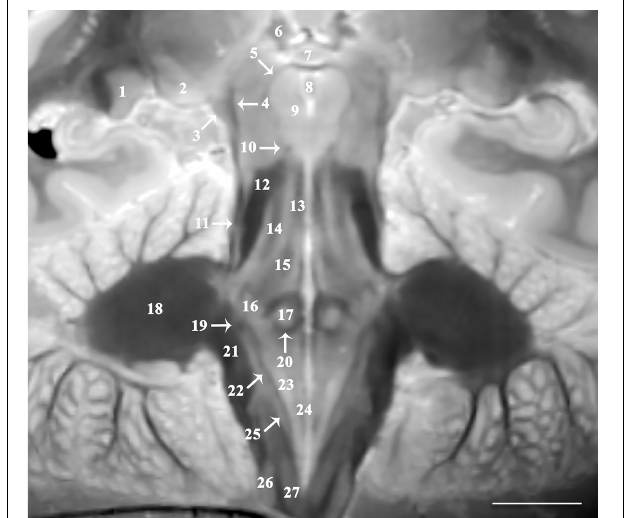
FIGURE 2 | Image oriented parallel and deep to the rhomboid fossa that is 15 o anterosuperior-to-posteroinferior oblique to the coronal intercommissural plane provides excellent visualization of lateral (1) and medial geniculate nuclei (2), brachium of the inferior colliculus (3), spinothalamic tract (4), mesencephalic trigeminal nucleus (5), habenular nucleus (6), posterior commissure (7), cerebral aqueduct (8), oculomotor nucleus (9), trochlear nerve (10), lateral lemniscus (11), superior cerebellar peduncle (12), medial longitudinal fasciculus (13), central tegmental tract (14), mesencephalic trigeminal tract (15), trigeminal nucleus (16), abducens nucleus (17), middle cerebellar peduncle (18), vestibular division of the vestibulocochlear nerve (19), genu of facial nerve (20), inferior cerebellar peduncle (21), solitary tract (22), dorsal motor vagal nucleus (23), hypoglossal nucleus (24), solitary nucleus (25), cuneate (26), and gracile nucleus (27) [scale bar = 10 mm]. Note the proximal optic radiations forming the dark lateral border of the lateral geniculate nucleus. The obliquity of the coronal image through both the spinothalamic tract (4) and the lateral lemniscus (11) gives the appearance of one contiguous structure. These are easily resolved as two distinct structures on the complete downloadable 3D